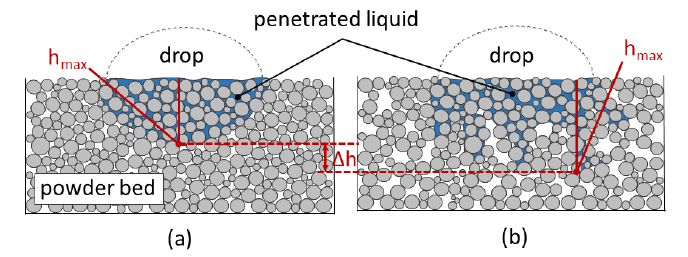
Figure 2. Schematic illustration of a powder bed with ( a ) a packing density and a compact fluid infil- tration present during BJ and ( b ) a loose powder bed with a finger-like infiltration pattern (modified from Miyanaji et al. [14]); the penetration depth h max in ( b ) is deeper than in ( a ), characterized by ∆ h .